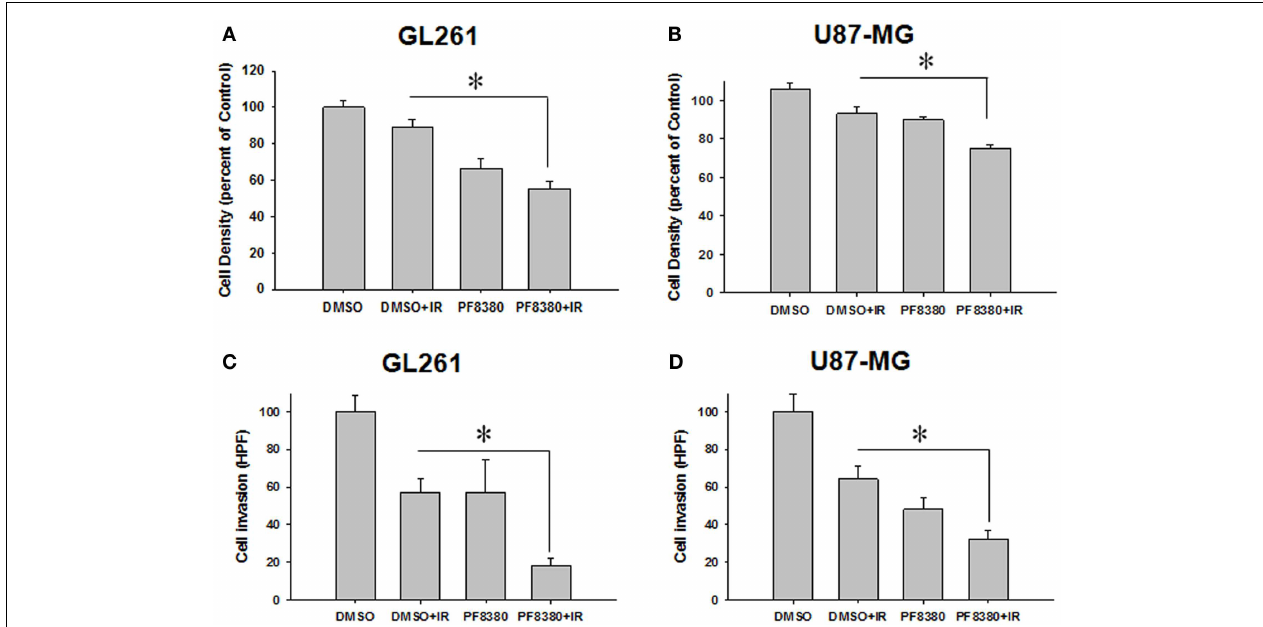
corresponding controls with SEM; * P > 0.05. Inhibition of autotaxin attenuates cell invasion in irradiated glioblastoma cells. GL261 (C) and U87-MG (D) cells were added to the eight micron inserts and were treated with 1 µ M PF-8380 or DMSO for 45min prior to irradiation with 4Gy. Cells were allowed to invade into the complete medium at the bottom of the inserts for 48h. Cells were fixed, stained, and cell invasion was calculated by counting the number of cells per HPF. Shown are the bar graphs representing the number of invasive cells with SEM; * P >